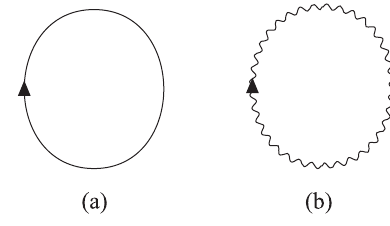
FIG. 9. Lowest-order diagrams for particle densities. There are corrections, which are expected to vanish at T ¼ 0